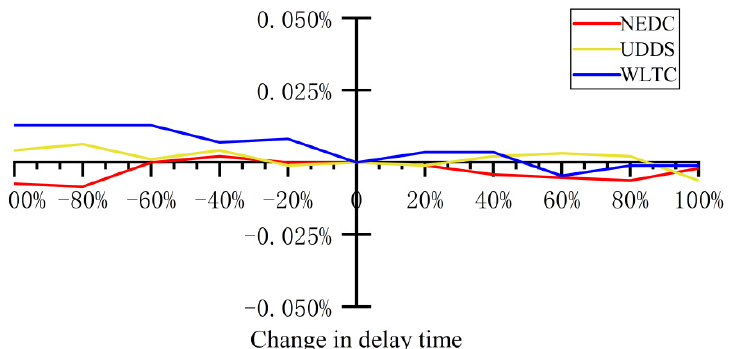
Figure 7. Sensitivity analysis of delay time values to SOC under different road conditions.